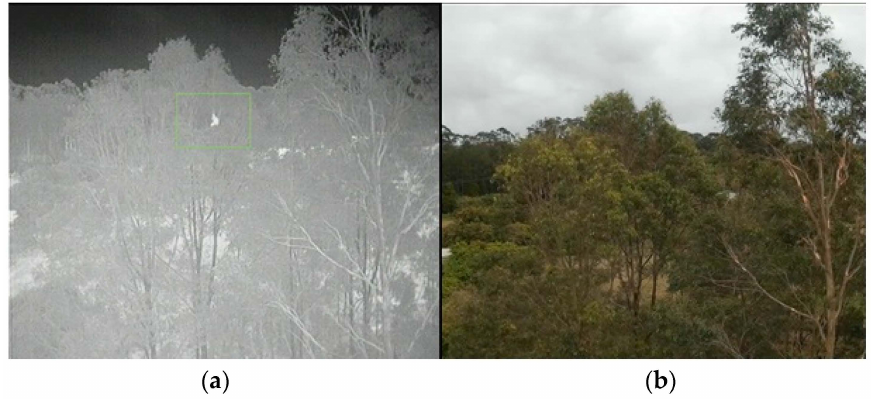
Figure 13. ( a ) Thermal image ( b ) digital lateral view at 20 m.